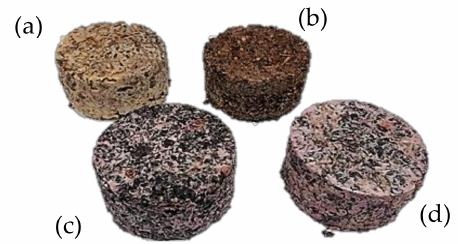
Figure 1. Composites ( a ) A/S, ( b )A/CS, ( c ) A/P, and ( d )